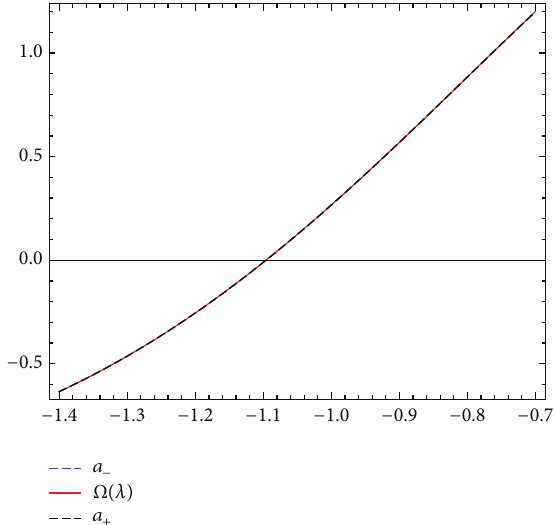
Figure 6: The enclosure interval dominating 𝜆 −2 for ℎ = 0.2 , 𝑁 = 25 , and 𝜀 = 10 −5 .